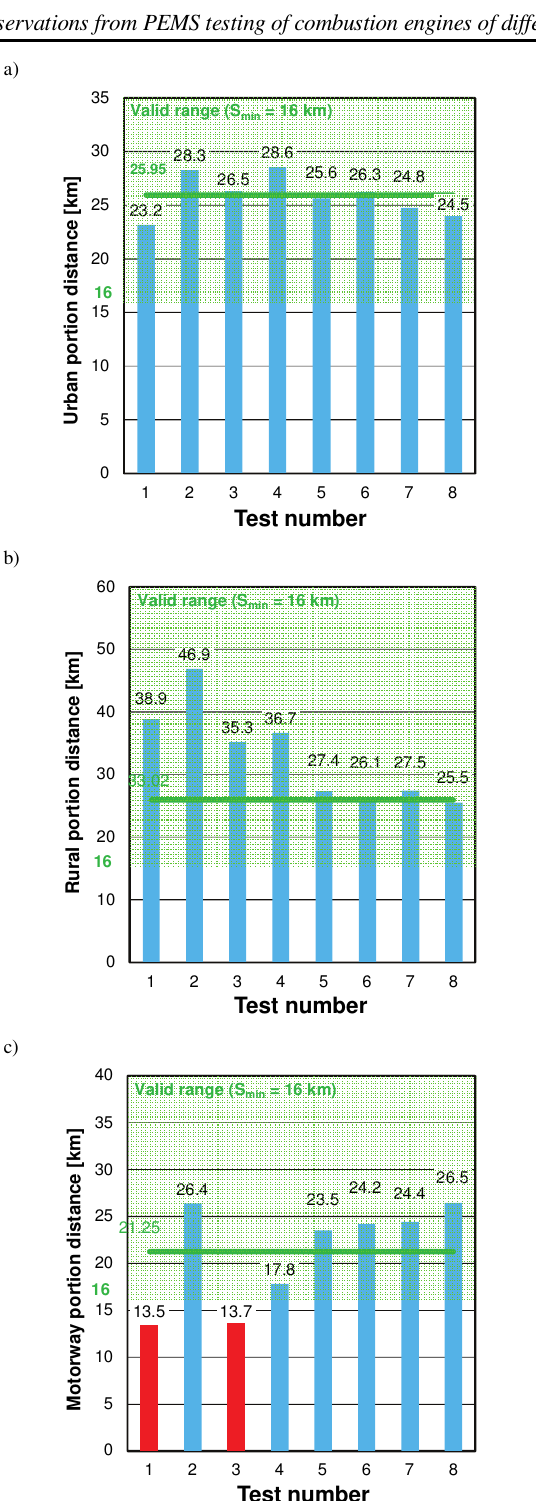
Test Fig. 4. Comparison of urban (a), rural (b) and motorway (c) section Fig. 5. Comparison of the urban (a), rural (b) and motorway (c) sections distances with a minimum value (required) for all drives as well as the share in the drive cycles with the limit values (required) indicated for all average drive cycles as well as the average value The average speed data analysis in the urban section showed that the highest speed was found for drive No. 2, and the smallest speed for drive No. 1. The average speed values of all drives are within the required range, i.e. from 15 km/h to 40 km/h (Fig. 6a). The drive cycle duration was the longest for the drive No. 4, and the shortest for the drive